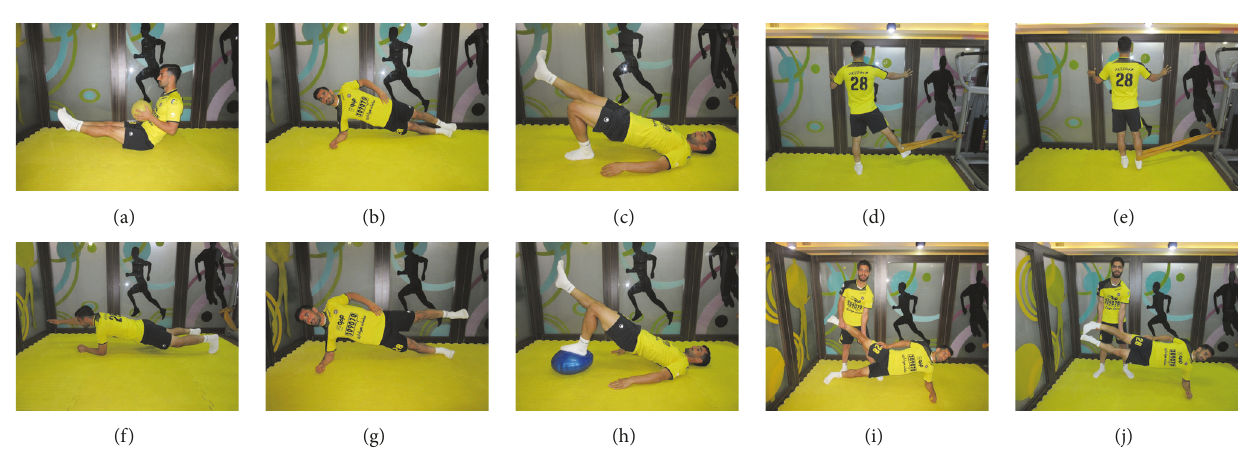
Figure 1: Some of the exercises that the participants performed during the first and second phases of modified H¨olmich et al. protocol. Descriptions are provided in Tables 1 and